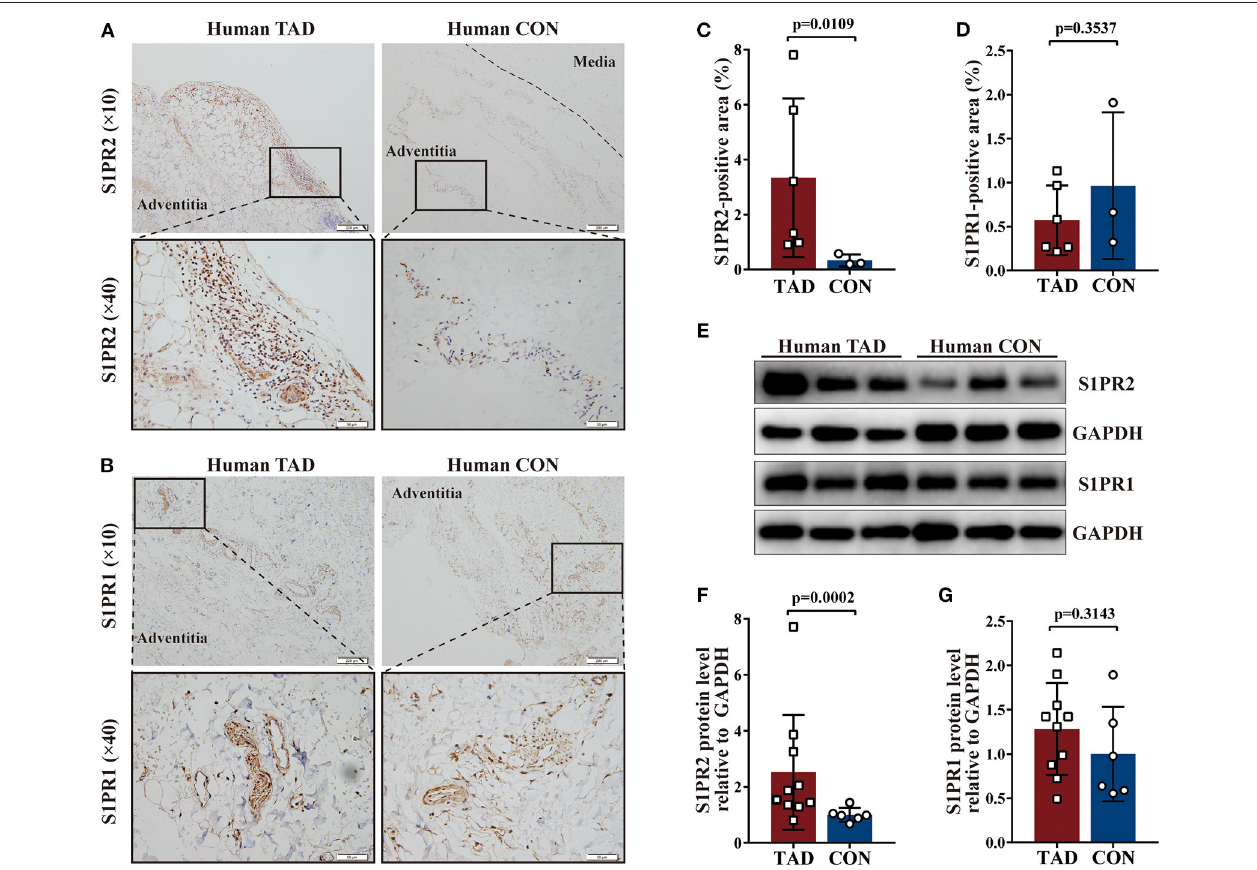
FIGURE 1 | Increased Sphingosine-1-phosphate receptor 2 (S1PR2) accumulation in human thoracic aortic dissection (TAD) lesions. Representative immunohistochemistry images and the corresponding analysis of human S1PR2 (A,C) and S1PR1 (B,D) in TAD lesions ( n = 6) and normal thoracic aorta ( n = 3). Representative immunoblot and the corresponding analysis of human S1PR2 (E,F) and S1PR1 (E,G) in TAD lesions ( n = 10) and normal thoracic aorta ( n = 6). Scale: 200 µ m, inset: 50 µ m. Data are expressed as means ±